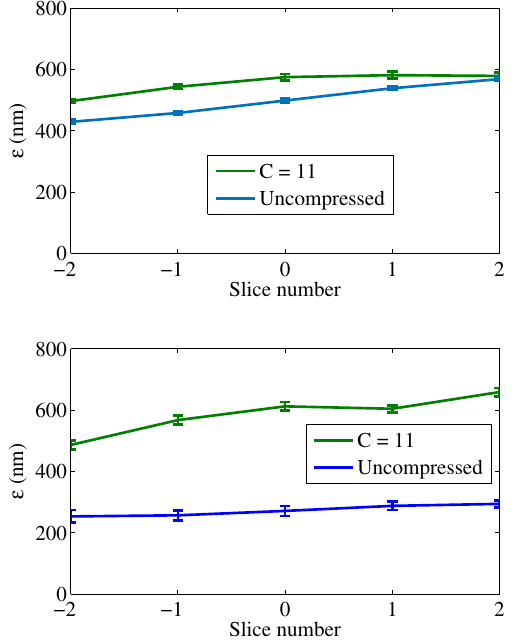
FIG. 6. Measured horizontal slice emittance starting from about 500 nm (top) and 250 nm (bottom) along the bunch after the compression. The maximum compression factor for both cases is